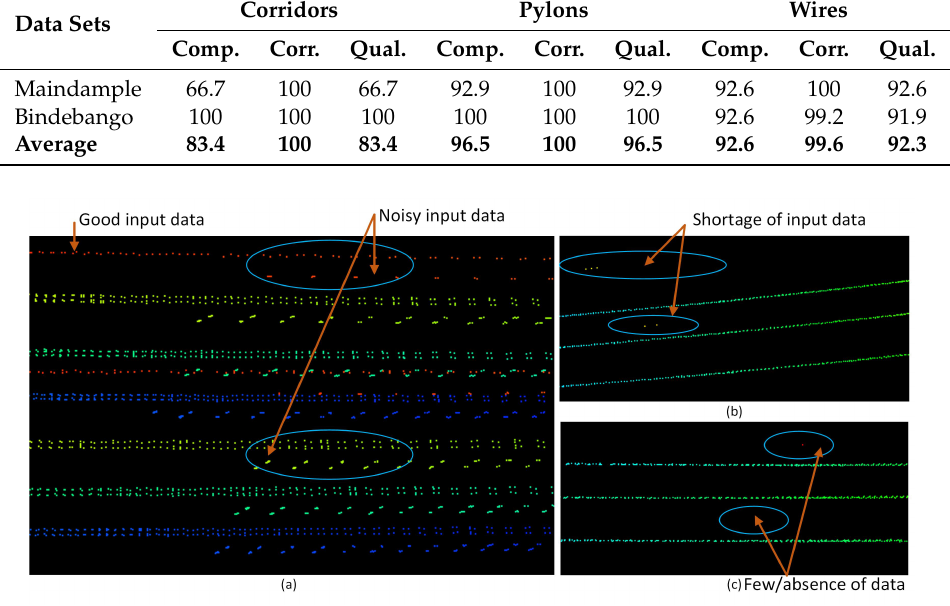
Figure 18. Complex cases of noisy and missing data: ( a – c ) Regions A–C indicated in Figure 15b,